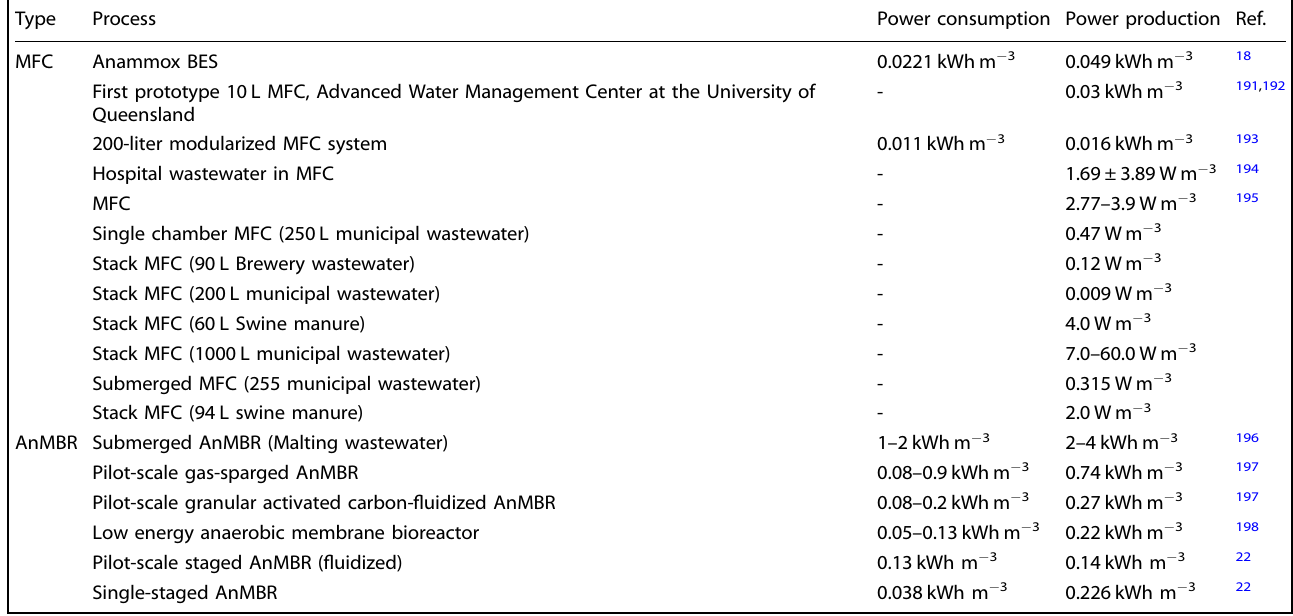
Table 3. A selective review of the studies on bioenergy and biohydrogen production using MFC and AnMBR. Type Process Power consumption Power production Ref.